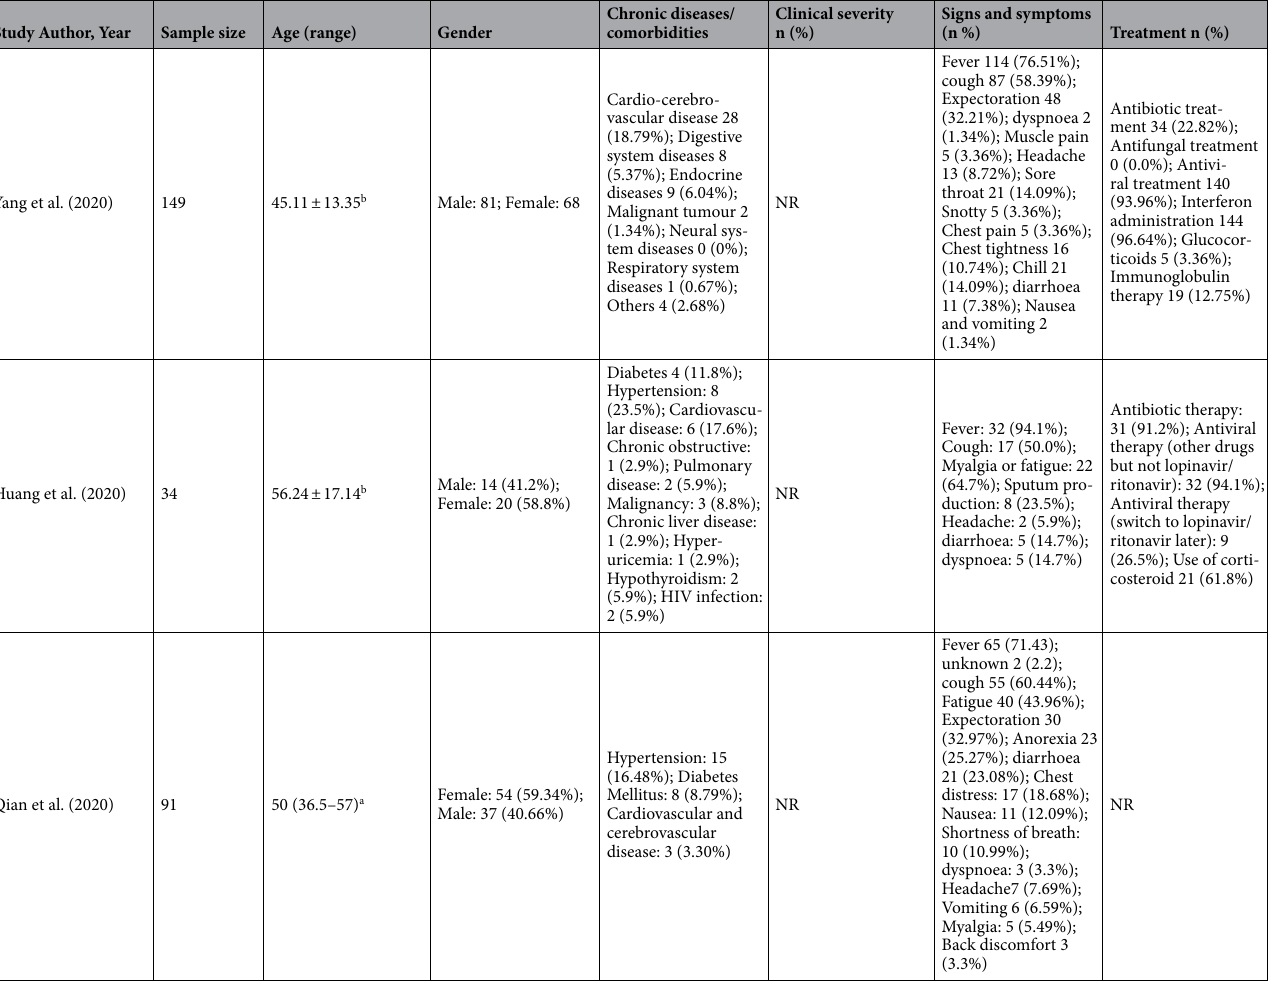
Table 3. Characteristics of participants in the included studies. T2DM type 2 diabetes mellitus, ACEi/ARBi Angiotensin II Receptor Blockers and angiotensin-converting enzyme inhibitor, NR not reported. a The Median with IQR. b Mean with SD. c The